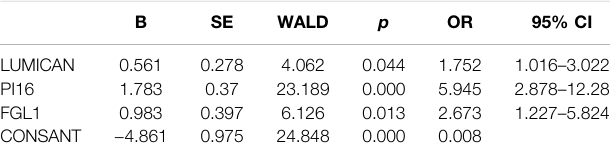
TABLE 8 | Logistic regression analysis results of AAD diagnosis with Lumican, PI16, and FGL1.